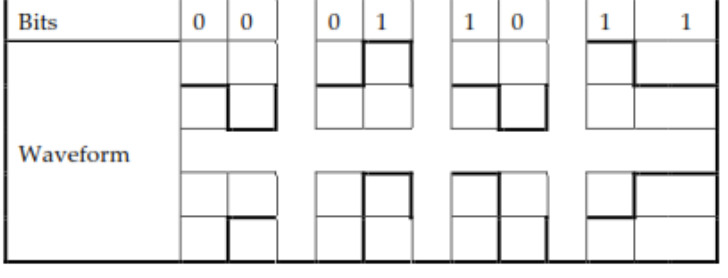
Figure 3. The basic structure of SES.